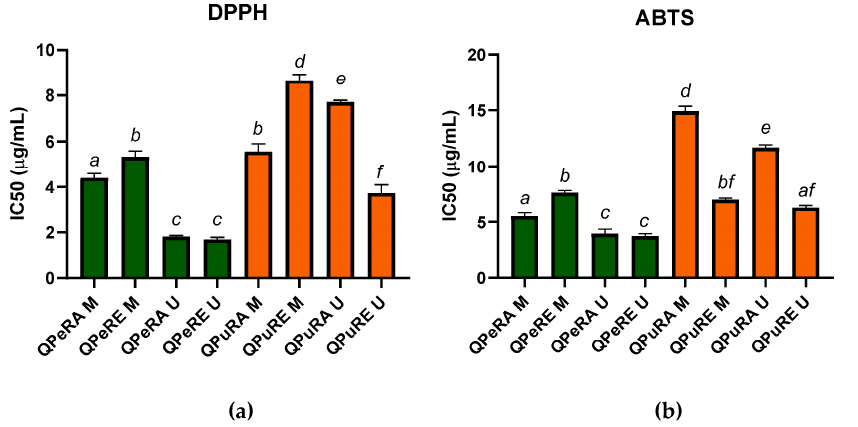
Figure 2. (a) Antioxidant capacity (DPPH method); (b) antioxidant capacity (ABTS method); differ- Figure 2. ( a ) Antioxidant capacity (DPPH method); ( b ) antioxidant capacity (ABTS method);